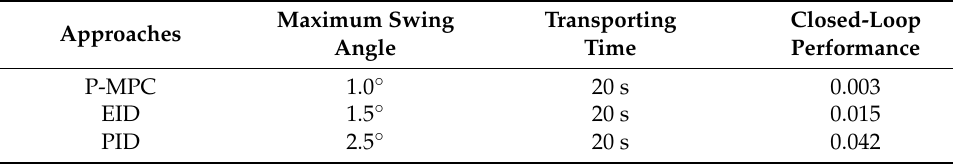
Table 3. The Comparison of the Three Approaches for Case